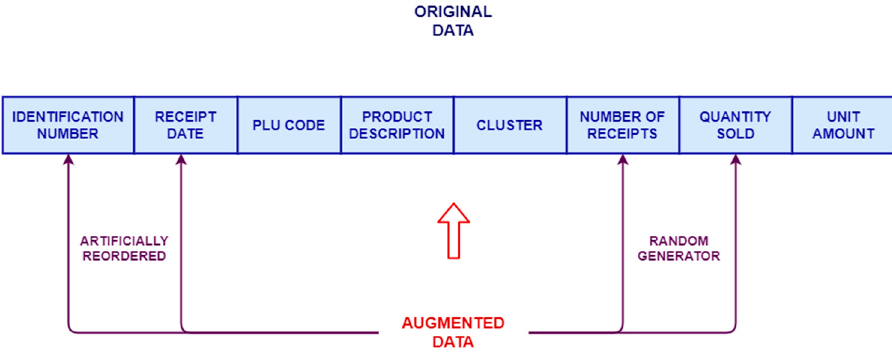
Figure 6. Schematic of the Augmented Data (AD) generation mechanism.